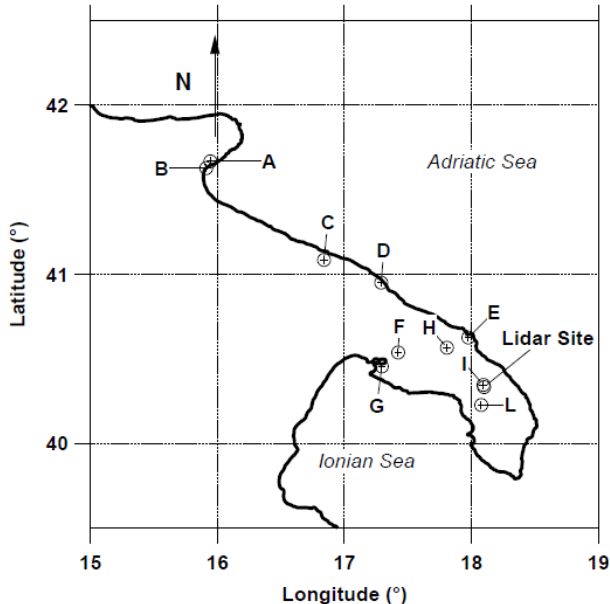
Figure 10 (M. R. Perrone et al.)